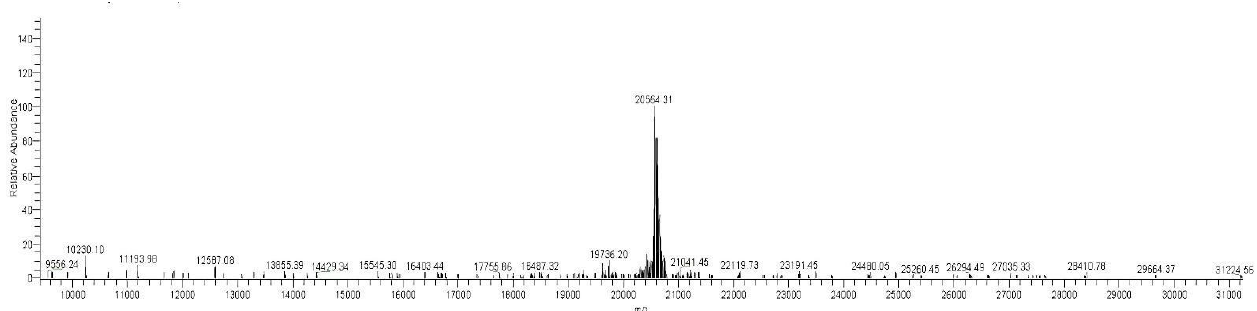
Figure 11. Molecular mass of MAP3773c. Mass spectrometry of MAP3773c with the monomeric form, using LC-MS. Total ion count LC-MS for MAP3773c demonstrated one peak. This peak represents a single, charged MAP3773c with an average mass of 20,564. Da.